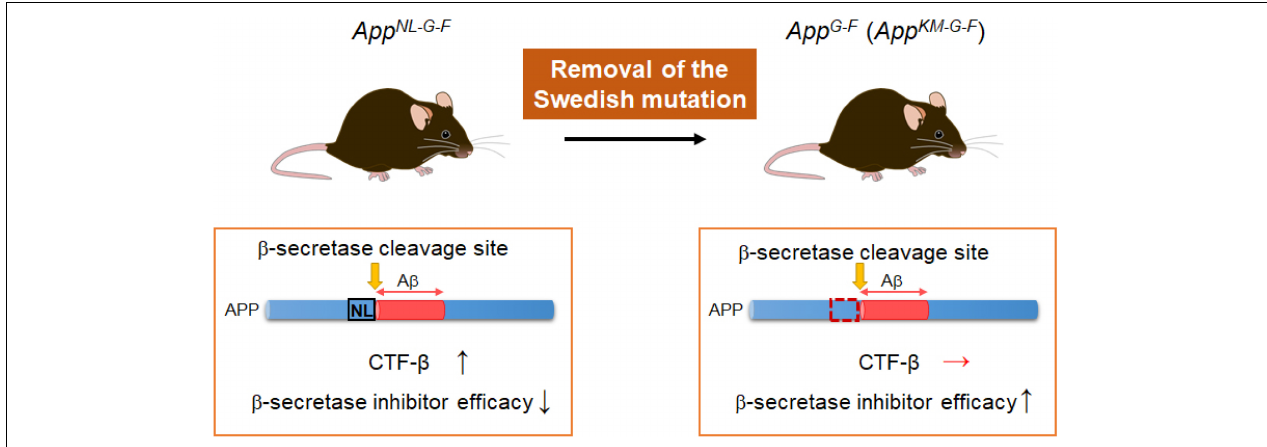
FIGURE 3 | App G − F mice suitable for studies of BACE1 inhibitors. The App G − F line is devoid of the Swedish mutation that influences the β -secretase activity and elevates the quantity of CTF β . (The App G − F line instead carries a wild-type sequence: KM.) The App G − F model would be appropriate for use in preclinical studies of β -secretase inhibitors without the interference of the Swedish